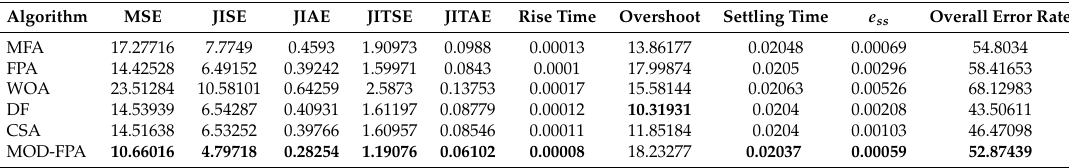
Table 11. Performance analysis, Case 2.